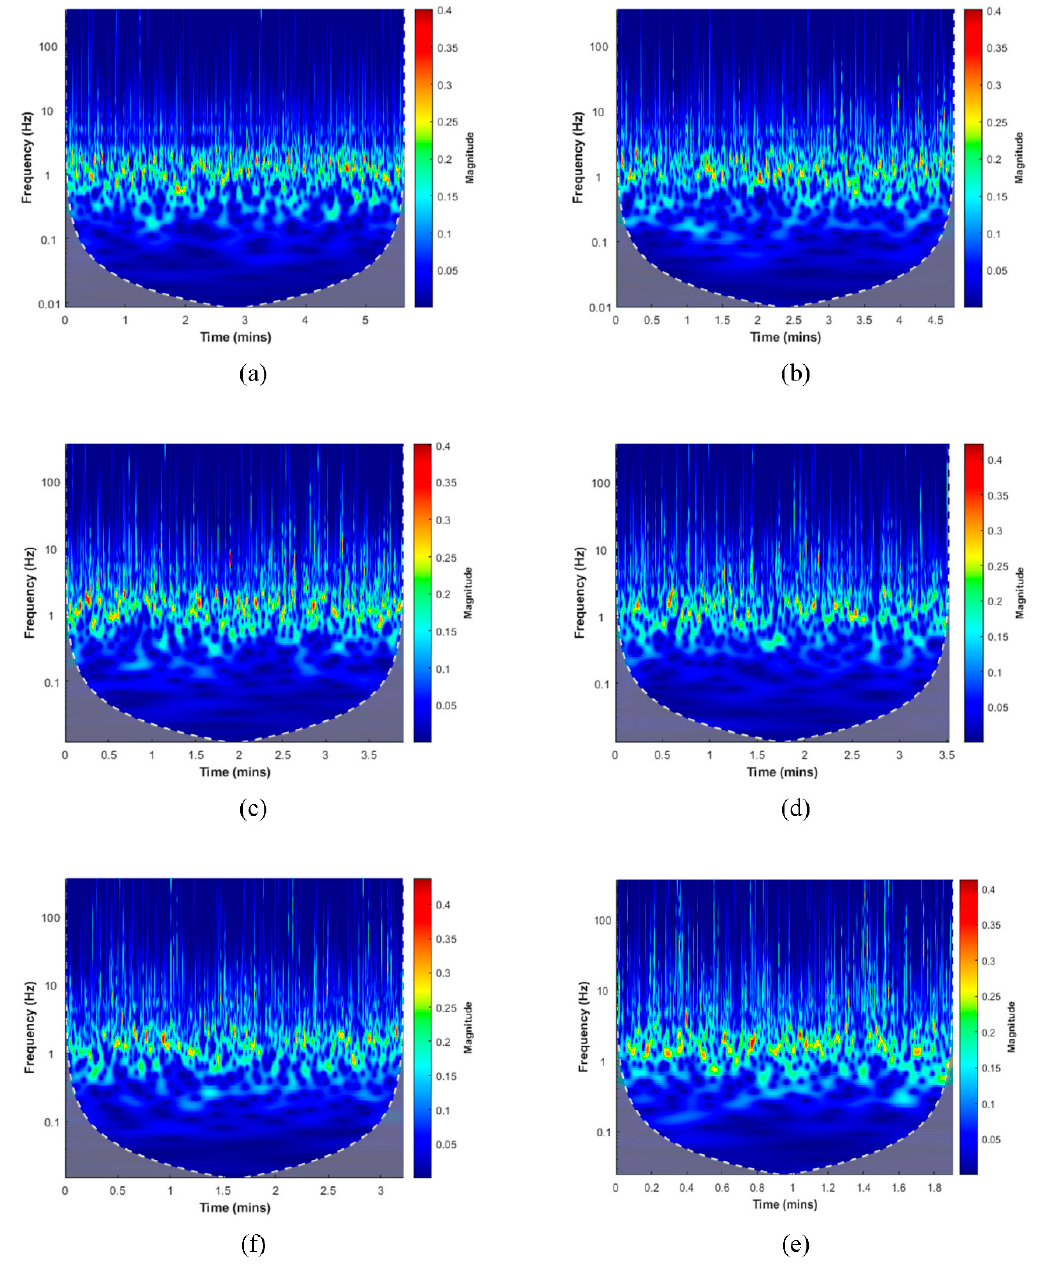
Figure 10. TFI energy concentration spectrum results of the battery RW9 measured voltage at different capacities: ( a ) 2.1, ( b ) 1.8, ( c ) 1.6, ( d ) 1.4, ( f ) 1.2, ( e ) 0.8 Ah. Table 2. TFIs energy concentration spectrum results of RW10, RW11, and RW12 LIBs measured voltage at different capacities.